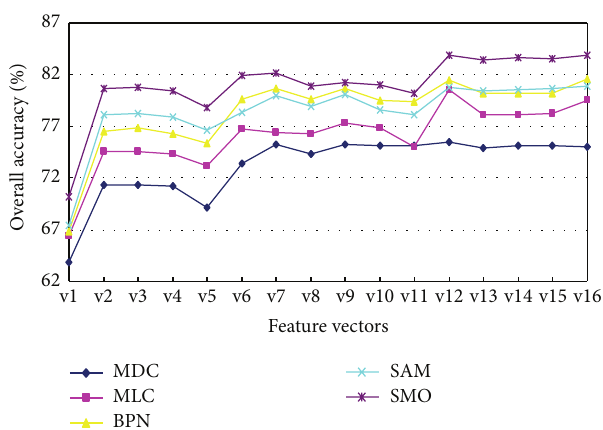
Figure 7: The effect on classification prediction time by different feature vectors and classification methods (experimental zone